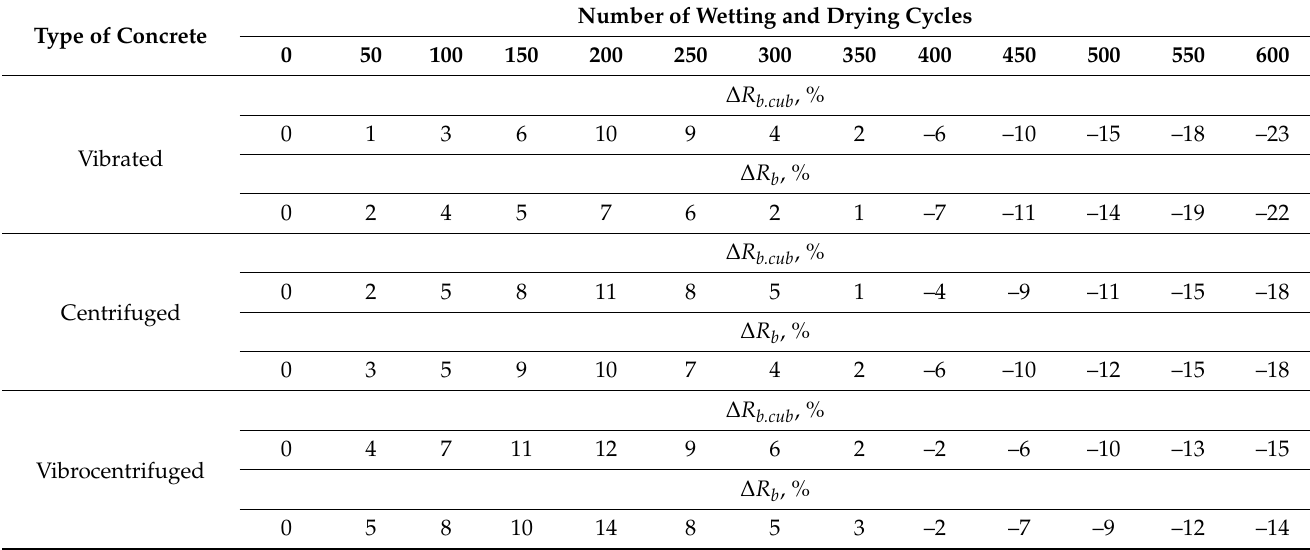
Table 7. Change in the strength characteristics of vibrated, centrifuged, and vibrocentrifuged con- cretes after cyclic wetting and drying at pH